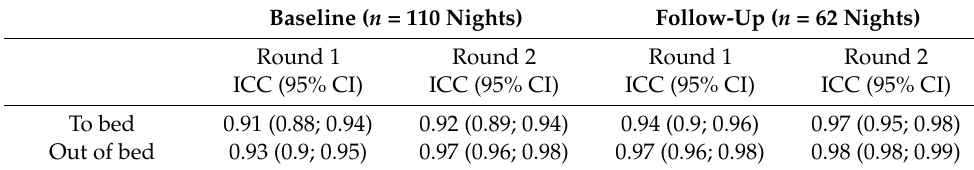
Table 5. Intraclass correlation coefficients between manual raters.